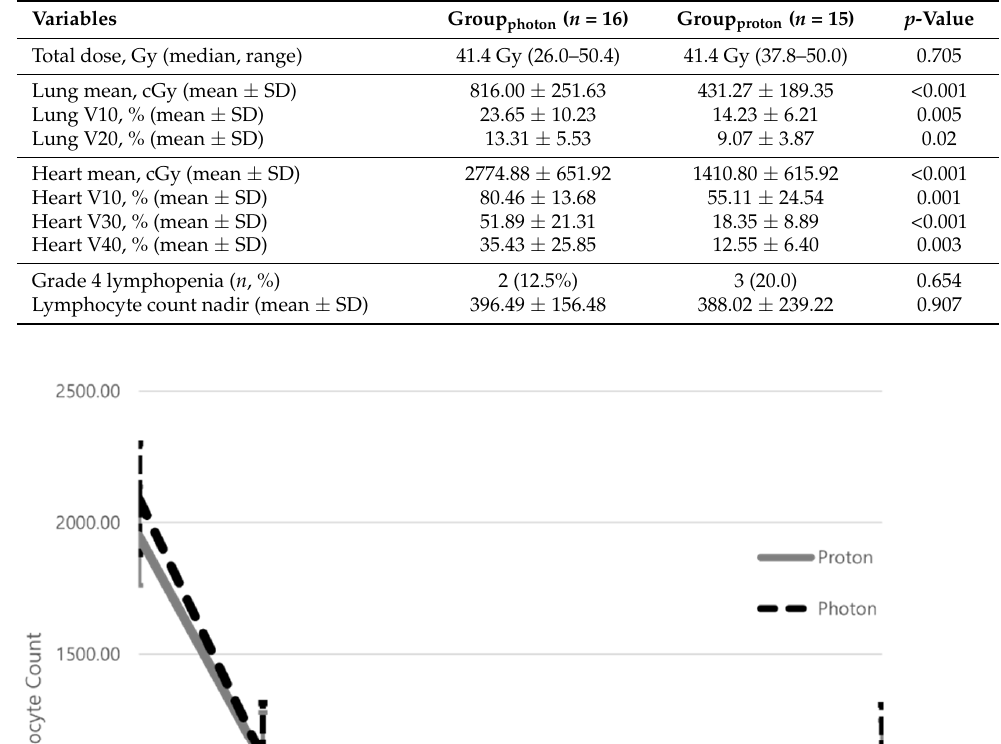
Table 2. Summary of dose volume histogram parameters and changes of lymphocytes during neoadjuvant chemoradiotherapy between Group photon and Group proton .